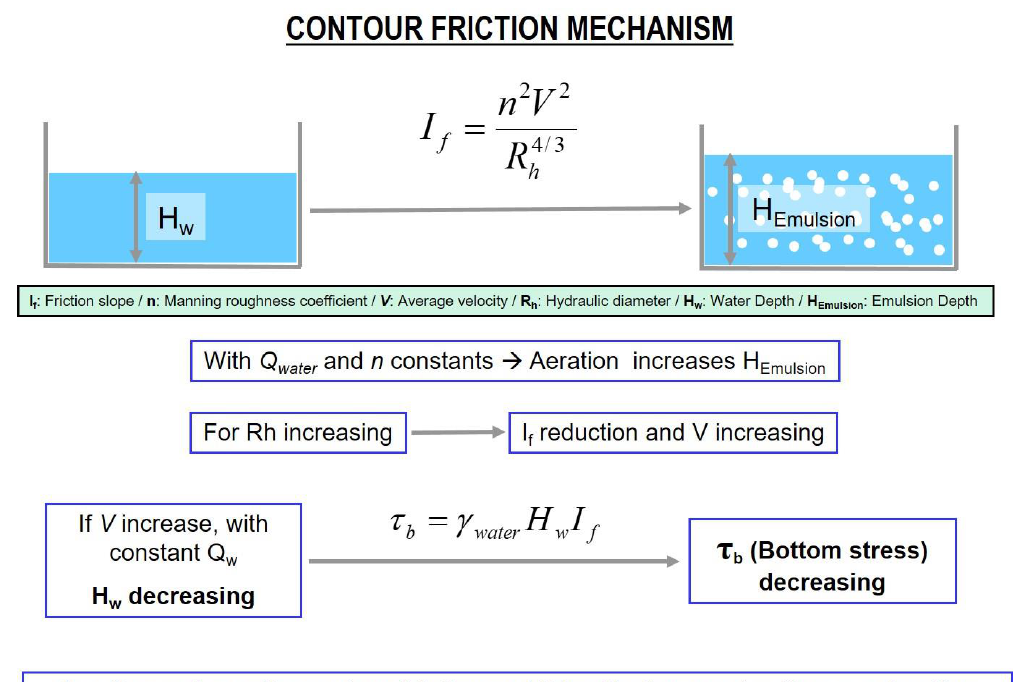
Figure 13. Scheme of the aeration effects over the boundary